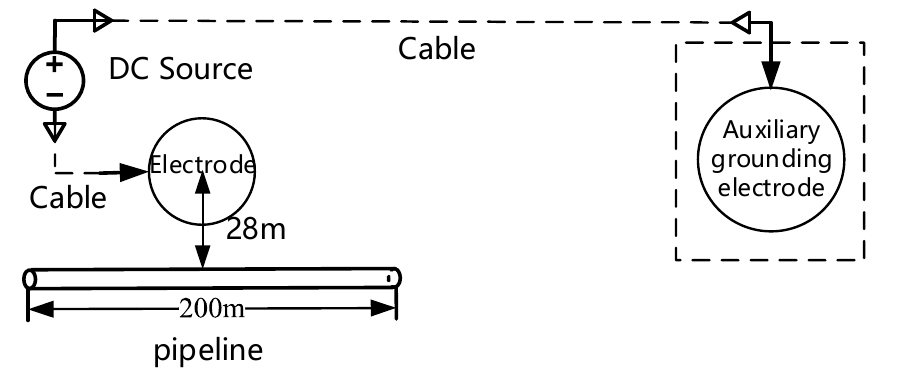
Figure 4. Layout of the scale experiment system.